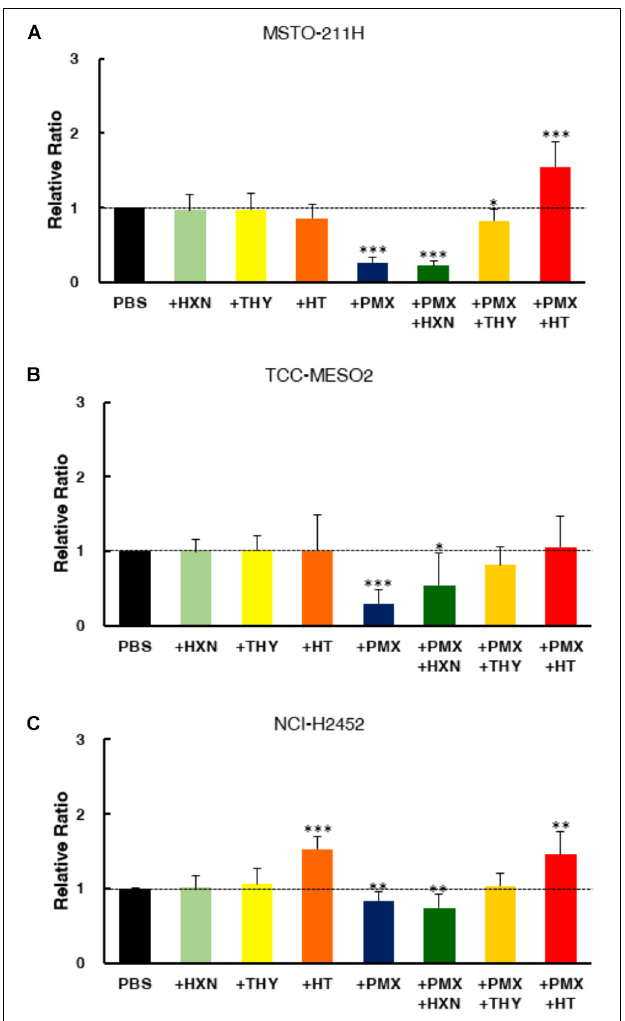
FIGURE 2 | End product reversal analysis of pemetrexed in MPM cells. Cell proliferation was measured with the WST-8 assay in the presence of either nucleotide precursor alone (thymidine: THY, hypoxanthine: HXN), pemetrexed (PMX) alone, or PMX + nucleotide precursor. Two pemetrexed-sensitive cell lines, MSTO-211H (A) and TCC-MESO2 (B) , and a pemetrexed-resistant cell line NCI-H2452 (C) were used- Black: PBS, Light Green: 100 µ M hypoxanthine (HXN), Light Yellow: 16 µ M thymidine (THY), Orange: 100 µ M hypoxanthine + 16 µ M thymidine (HT), Blue: Pemetrexed (PMX) 1 µ M, Green: